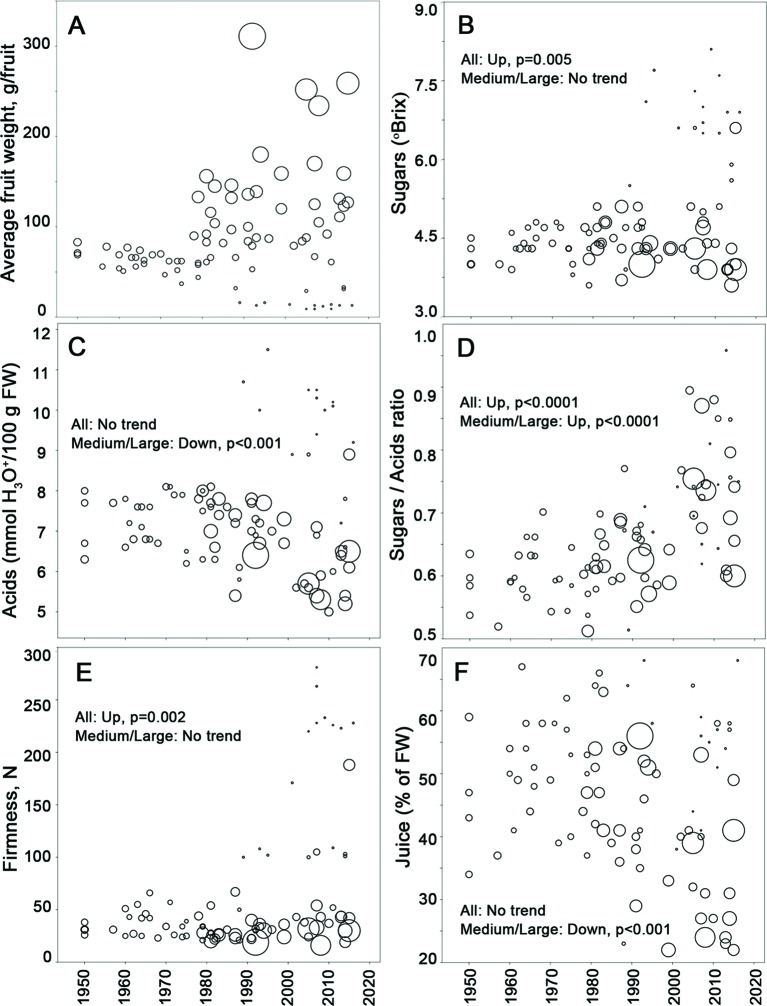
The development of average fruit weight and the basic fruit flavor parameters of tomato varieties, commercially introduced between 1950 and 2016. Each variety is represented by a circle, whose size is proportional to its average fruit weight. Significance of quantitative trends is indicated with p-values of Mann-Kendall trend test for all varieties analyzed (All) and for medium-sized and large fruited tomatoes with average weight >25 g per fruit (Medium/Large). (A) Average fruit weight, g/fruit, (B) Sugar content in ripe fruit measured as refraction index, ºBrix, (C) Titratable acids in ripe fruit, mmol H3O+/100 g FW, (D) Sugar/Acid ratio in ripe fruit, (E) Firmness of ripe fruit, N, (F) Amount of liquid (juice) released by ripe fruit, % of FW.